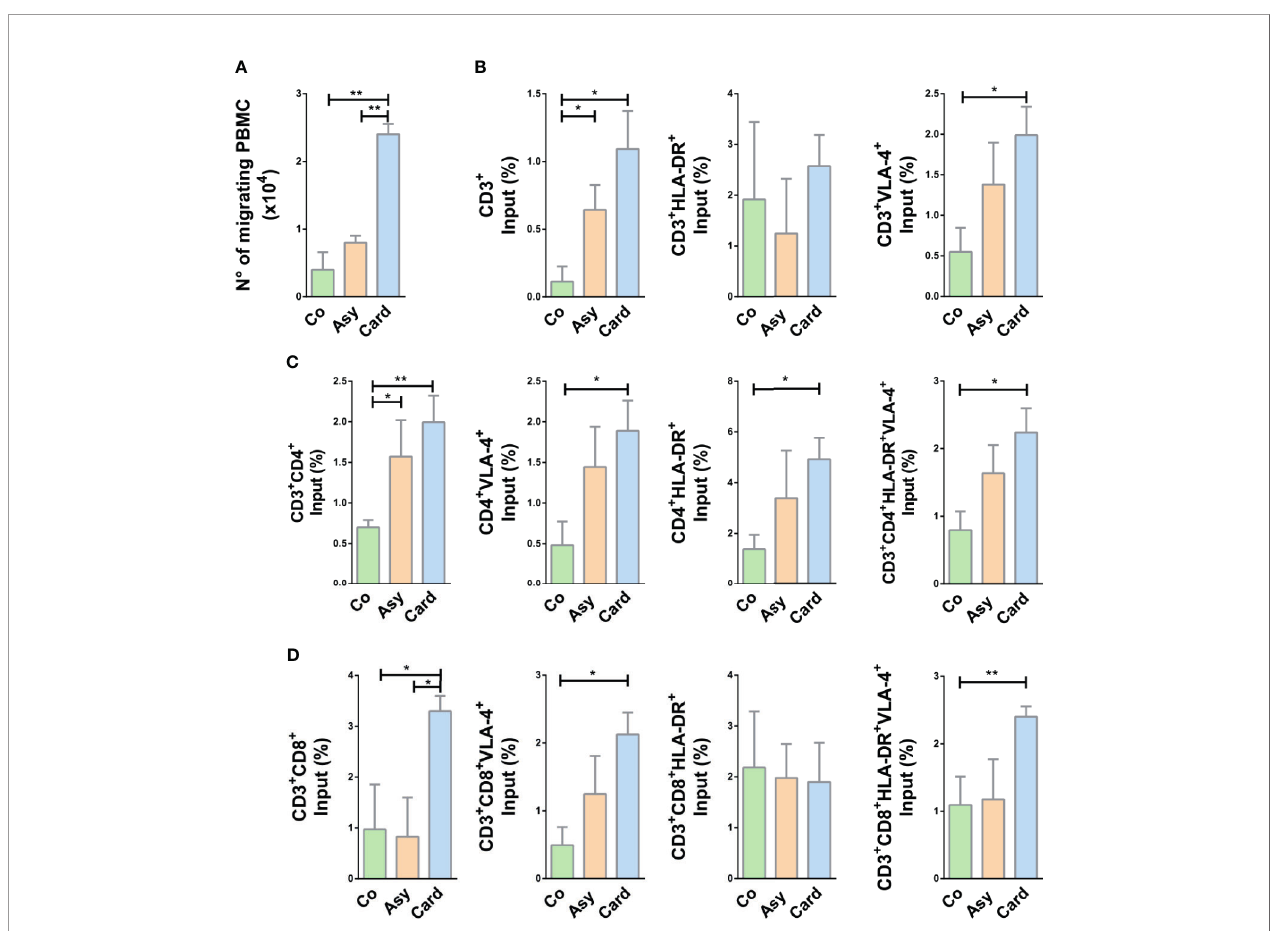
FIGURE 3 | Migratory capacity of T cells from chagasic patients over fi bronectin. (A) The graph shows the absolute number of migrating peripheral blood mononuclear cells (PBMC). (B) Percentage of input of CD3+ T cell subpopulations. (C) Percentage of input of CD4+ T cell subset. (D) Percentage of input of CD8+ subpopulations. In all cases, cells were allowed to migrate in transwell chambers coated with fi bronectin or BSA. The values shown correspond to speci fi c migration after subtracting numbers obtained for each sample in wells coated with BSA alone. *p < 0.05 and **p < 0.01 versus Controls. Kruskal-Wallis followed by Mann-Whitney U test were used for statistical analyses. Co, Control (n = 20); Asy, Asymptomatic (n = 20); Card, Cardiac (n =